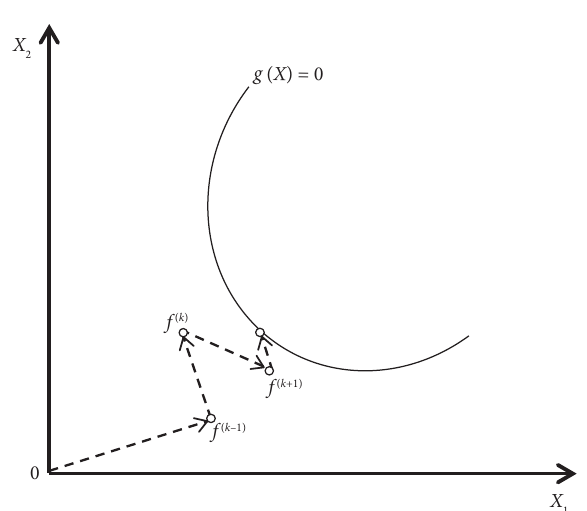
Figure 3: Iteration process diagram of gradient iteration